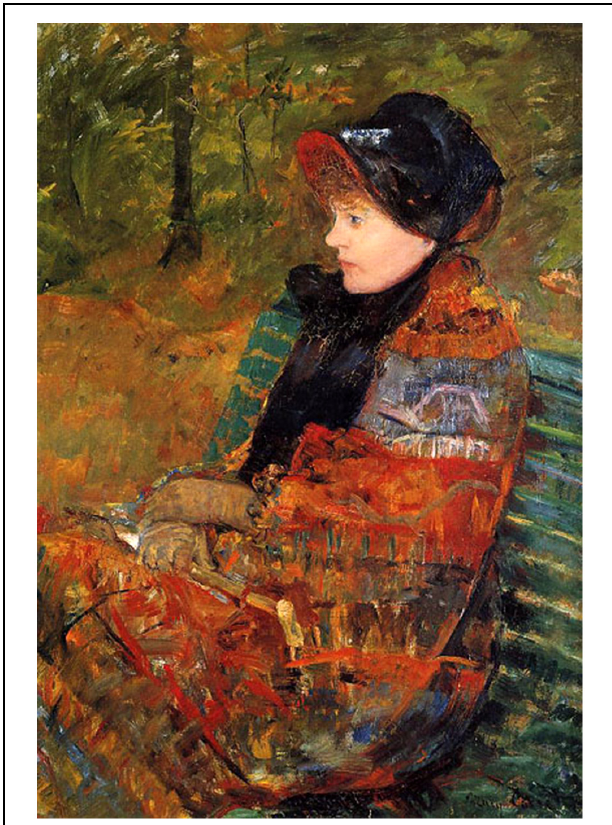
FIGURE 1 | Profile of Lydia Cassatt (1880). This portrait entitled Autumn of the seriously ill Lydia by her sister, Mary Cassatt, can be interpreted as showing her losing her identity (copied from http://hoocher.com/Mary_ Cassatt/Mary_Cassatt.htm original in the Musee du Petit Palais, Paris, France).